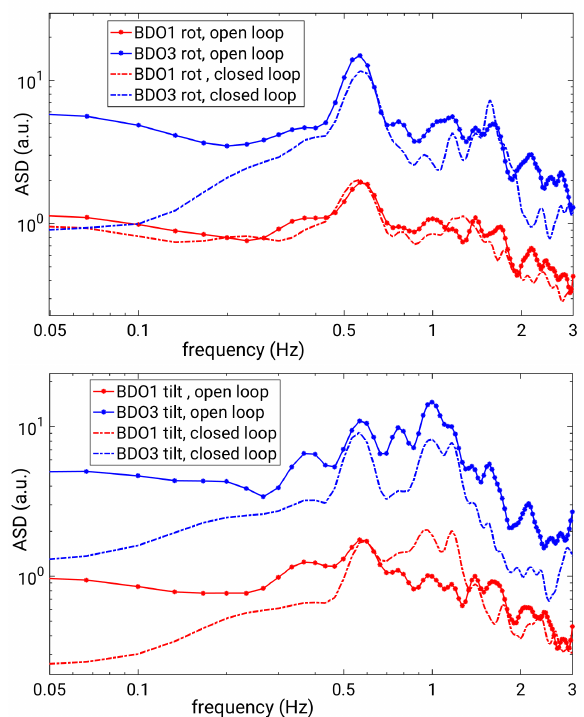
Figure 3. Amplitude spectra of the MDWS error signals at the near and far QPD for the horizontal ( top ) and vertical ( bottom ) plane. The loops in which more suppression is visible are at a higher gain.